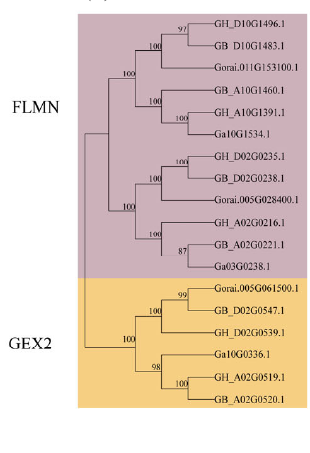
Figure 4. The gene structure, conserved motifs and domains in Filamin gene family members of four cotton species. ( A ) The ML phylogenetic tree was constructed based on the full-length sequences of four cotton species Filamin gene family members by using MEGA 7.0 software. Different subfamilies are indicated by different colors. ( B ) Exon–intron structure of four cotton species Filamin gene family members. Light green for exons; black lines for introns. ( C ) Conserved motif of four cotton species. Different colored squares represent different motifs, named motif1–motif10. ( D ) The conserved domains in four cotton species Filamin gene family members.